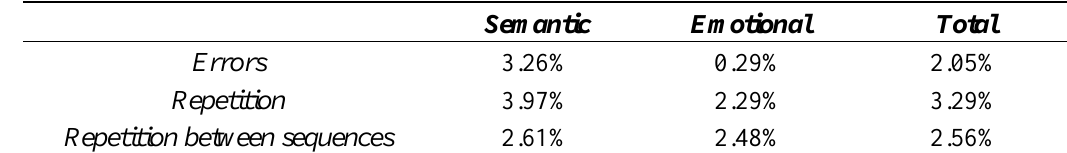
Table 2. Error and repetition rates per overall category.